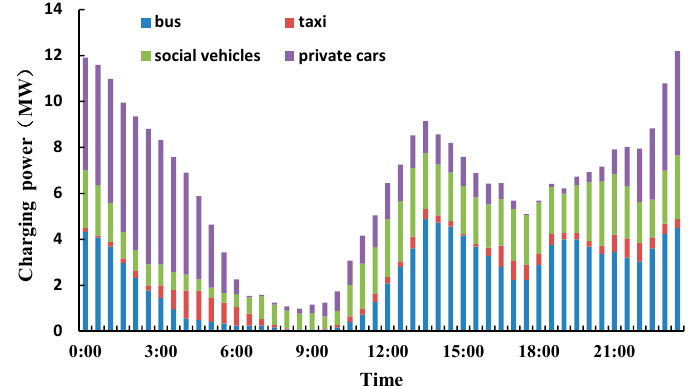
Figure 12. Electric vehicle charging load profile for different types of EV.